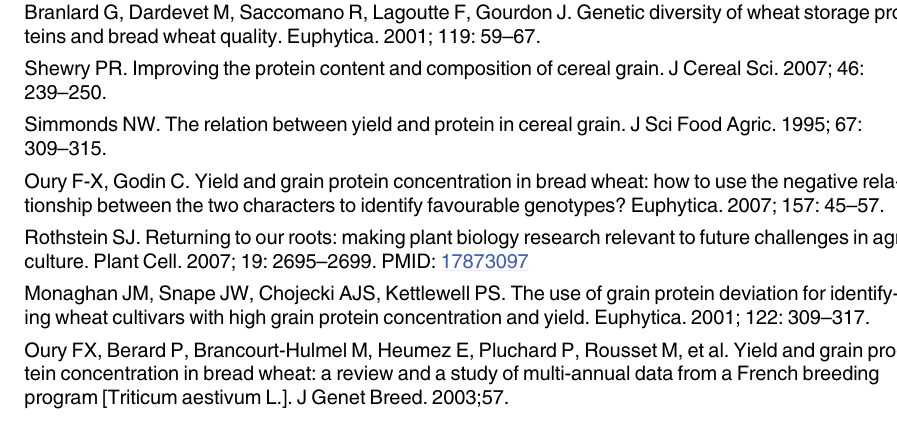
S1 Table. Elemental composition of nutrient solutions adapted from Castle and Randall (1987). S2 Table. Target gene name, accession number and primer sequences of primer couples used in the study. S3 Table. Roots, stems and flag leaves NO 3- concentration at flowering for two contrasted NO 3- treatments (N4 and N10). Presented values are the mean of four biological repetitions ± 1 standard error (SE). Statistically non-significantly different groups (Tukey multiple compari- sons, p < 0.05) are labeled with the same lowercase letter. S4 Table. Grain number and thousand-kernel-weight at maturity for the four NO 3- treat- ments. Presented values are the mean of four biological repetitions ± 1 standard error (SE). Sta- tistically non-significantly different groups (Tukey multiple comparisons, p < 0.05) are labeled with the same lowercase